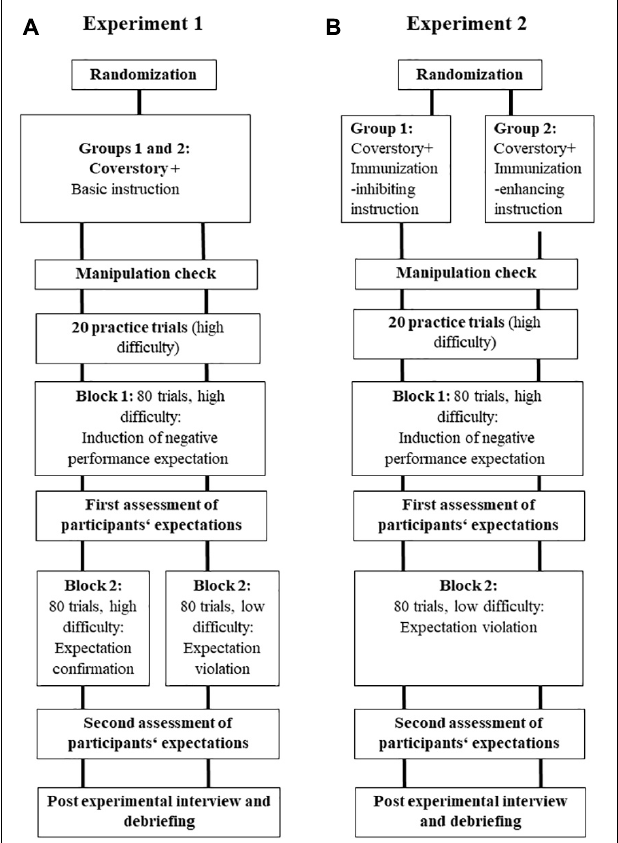
FIGURE 1 | The basic procedure of the two experiments. Experiment 1 (A) : A cover story, a training block and a test block induced negative expectations regarding one’s ability to succeed in an unknown test. After the first test block, we assed participants’ expectations. The procedure continues with a second test block with either a high (group 1) or a low (group 2) difficulty to confirm (group 1) or disconfirm (group 2) the initial expectation. Afterward, we assessed participants’ expectations for the second time followed by a post-experimental interview and debriefing. Experiment 2 (B) : A cover story and additional immunization-inhibiting (group 1) or enhancing (group 2) instructions mark the beginning of the experiment. Afterward, we presented a training block as well as a test block induced negative expectations regarding one’s ability to succeed in an unknown test. After the first test block, we assed participants’ expectations. The procedure continues with a second test block low difficulty to disconfirm the initial expectation. Afterward, we